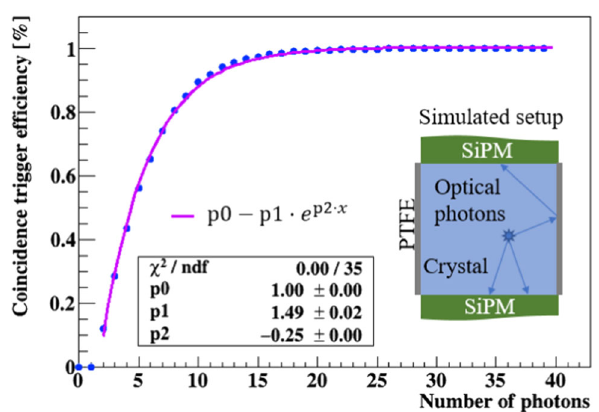
Fig. 15 Two-PE coincidence trigger efficiency as a function of the number of emitted photons in the proposed detector. Taken from Ref. [60]